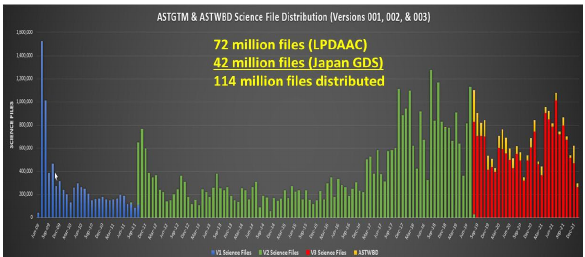
Figure 6 . Distribution statistics for ASTER GDEMs Versions 1, 2, and 3. Version 3 numbers are in